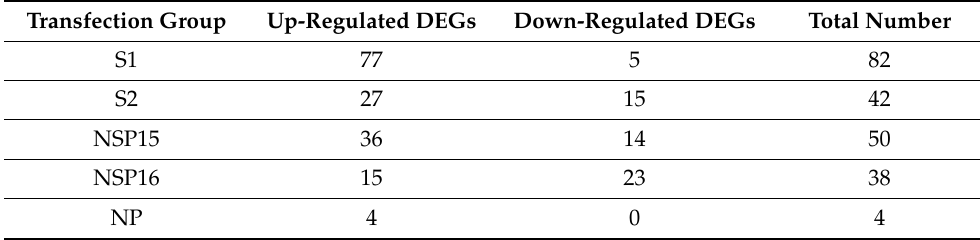
Table 2. Summary of the numbers of up-regulated and down-regulated DEGs in HL-CZ